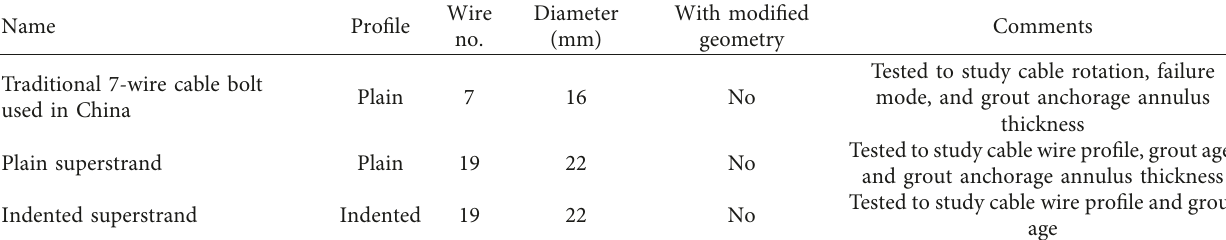
Table 1: Specification of tested cable